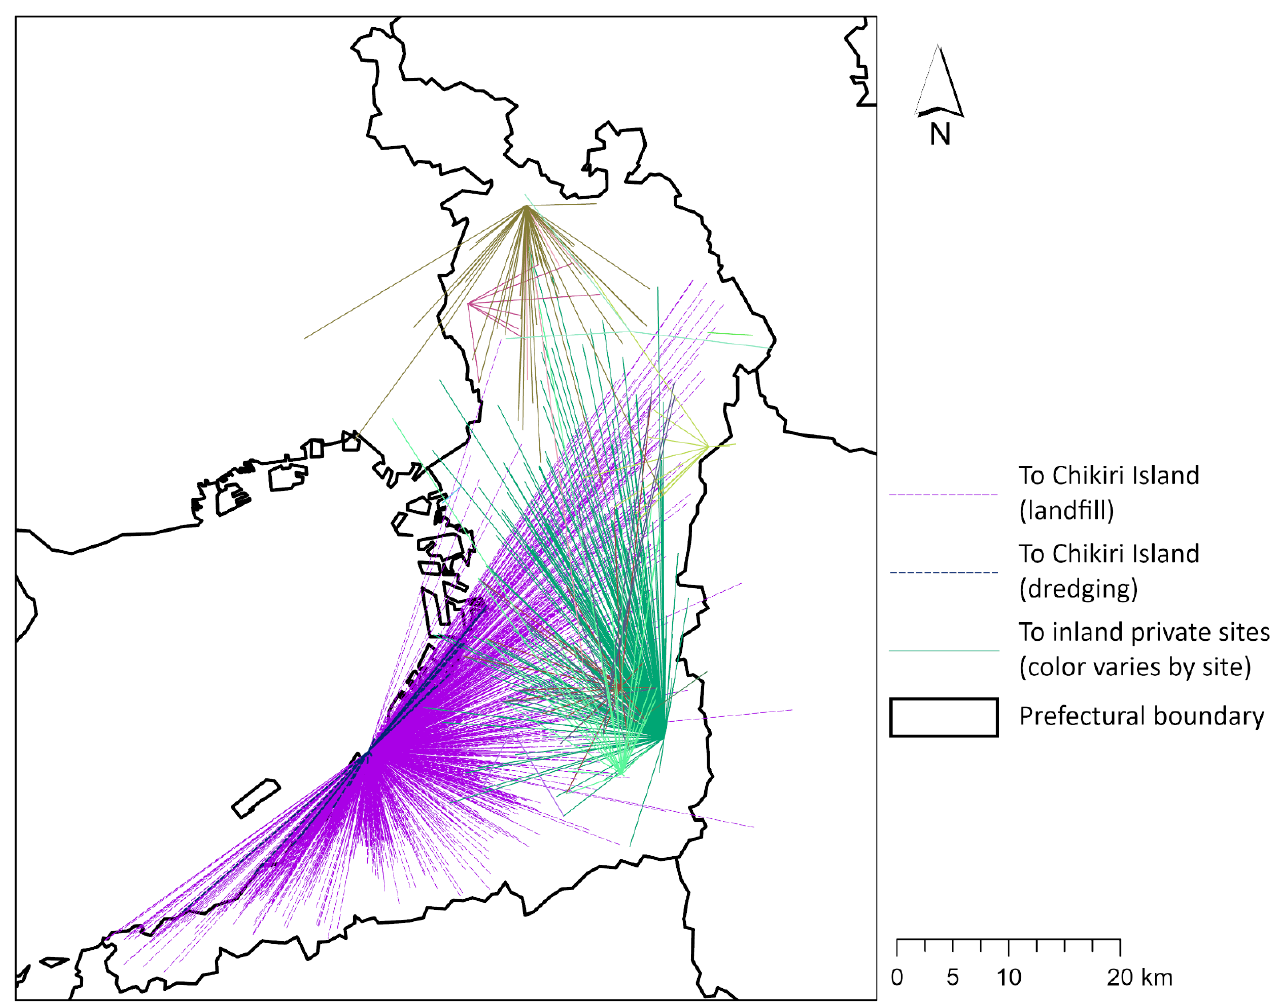
Figure 5. Current fill material flows in Osaka Prefecture. Flows are color-coded by acceptance site and type of fill material.